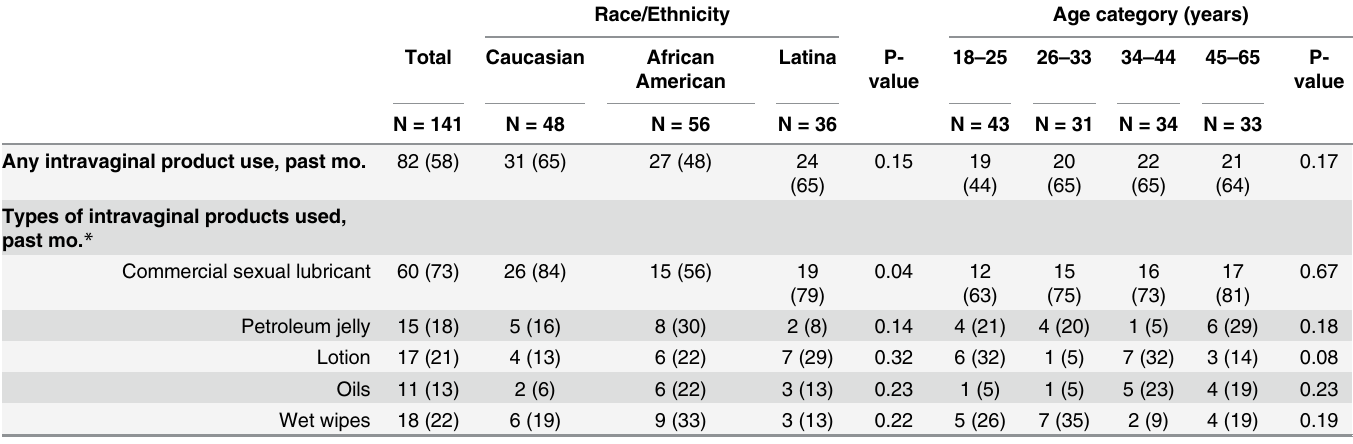
Table 3. Intravaginal insertion of products over the last month, by race/ethnicity and age.